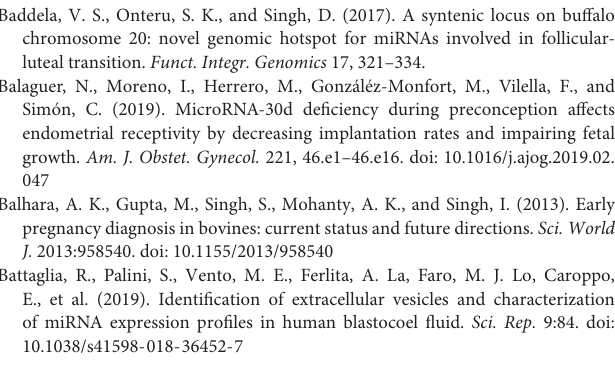
Supplementary Figure 1 | Venn diagram for miRNAs identified in early and mid stage sample of maternal placentome. Supplementary Figure 2 | Venn diagram for miRNAs identified in early and mid stage sample of fetal placentome. Supplementary Figure 3 | Heat map for the differential abundance of miRNA between the early and mid stage fetal placentome. Supplementary Figure 4 | Heat map for the differential abundance of miRNA between the early and mid stage maternal placentome. Supplementary Figure 5 | Examples of secondary structure prediction of Novel microRNAs in fetal placentome. Supplementary Figure 6 | Examples of secondary structure prediction of Novel microRNAs in maternal. Supplementary Figure 7 | Relative miRNA abundance of miR-379-5p, miR-195-5p, and miR-708-3p in the blood plasma of pregnant, non-pregnant, prepubertal, and cyclic heifers not bred at day-19 and day-25 of pregnancy. Supplementary Figure 8 | Relative miRNA abundance of miR-130a-3p and miR-200a-3p in the blood plasma of pregnant, non-pregnant, prepubertal, and cyclic heifers not bred at day-19 and day-25 of pregnancy. Supplementary Table 1 | The summary of raw and trimmed reads used for the analysis. Supplementary Table 2 | Total number of Identified miRNA. Supplementary Table 3 | List of Primers. Supplementary Table 4 | List of top 20 differentially expressed miRNAs with their associated placentome